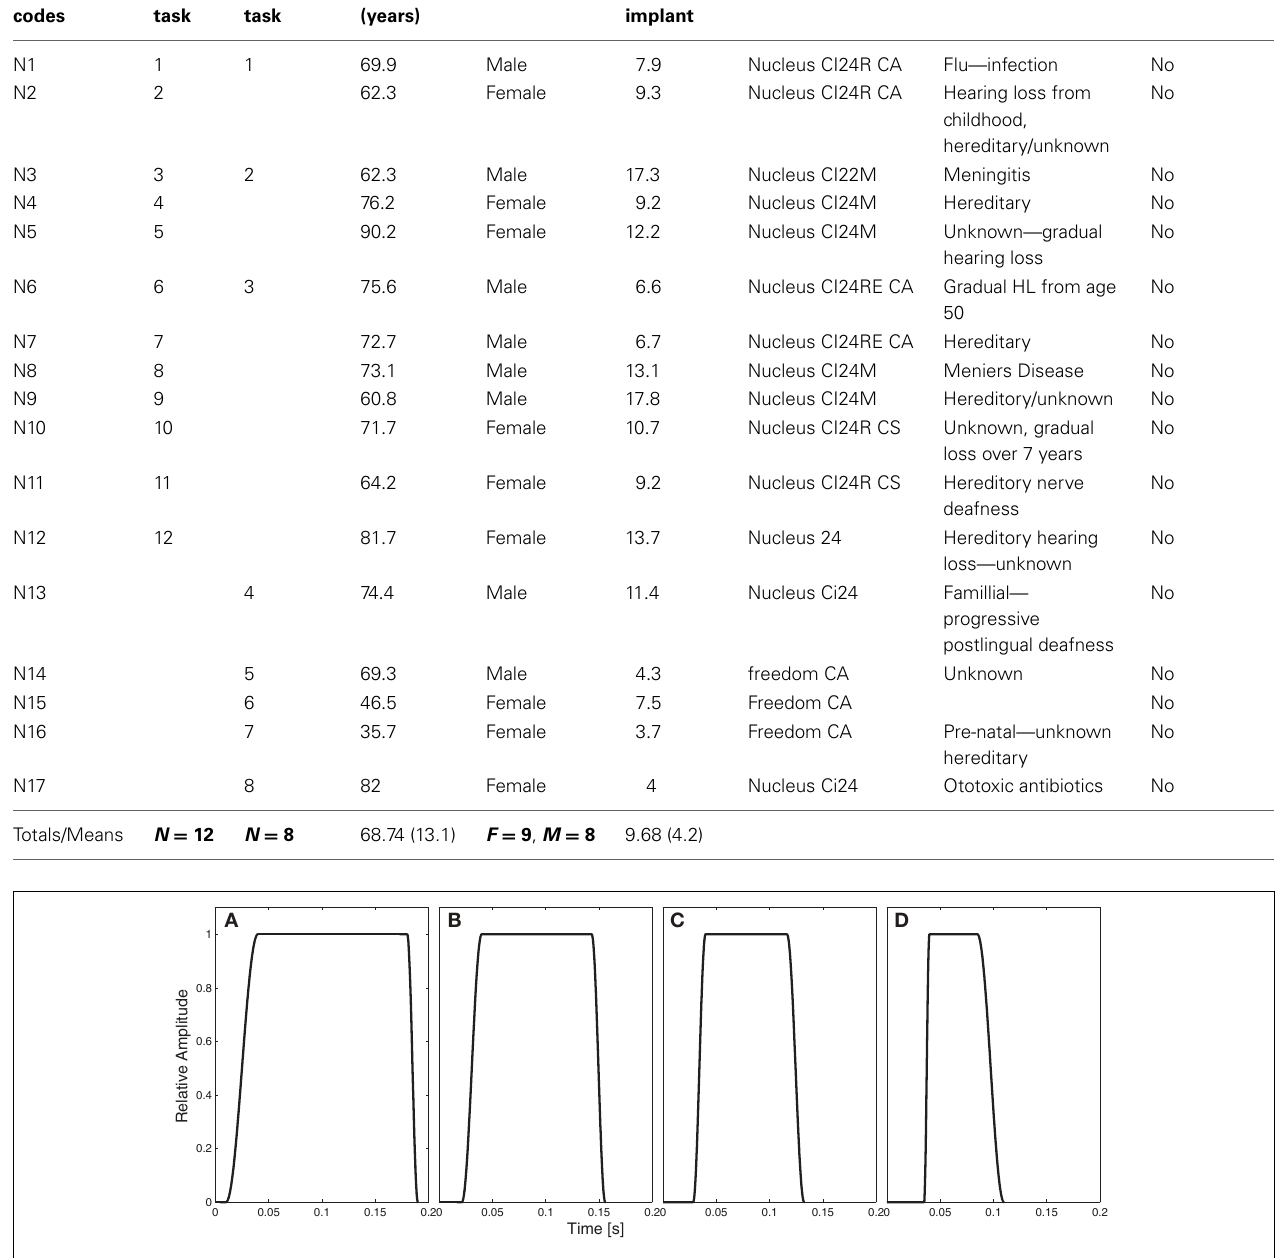
FIGURE 1 | Temporal envelope of the stimuli for different level of impulsiveness: (A) 160ms (ratio of distractor to target impulsiveness of 100%), (B) 119ms (ratio: 74%), (C) 90ms (ratio: 56%), and (D) 60ms (ratio: 37.5%).